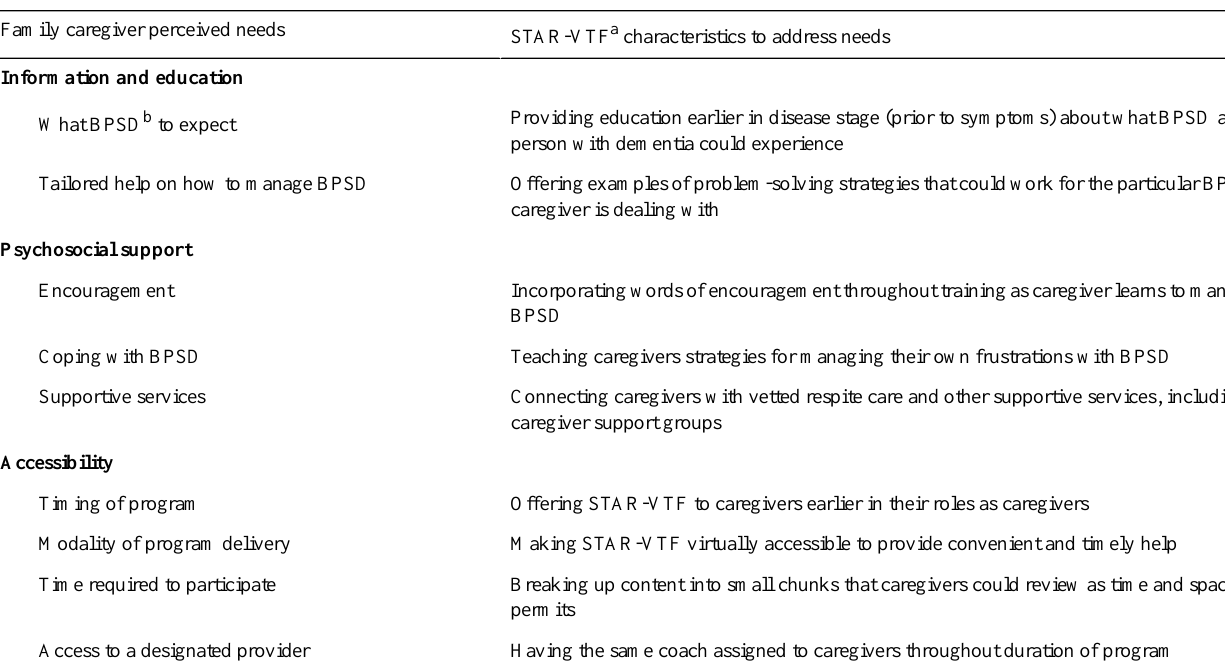
Table 2. Summary of caregivers’perceptions about needs and STAR-VTF characteristics that would address